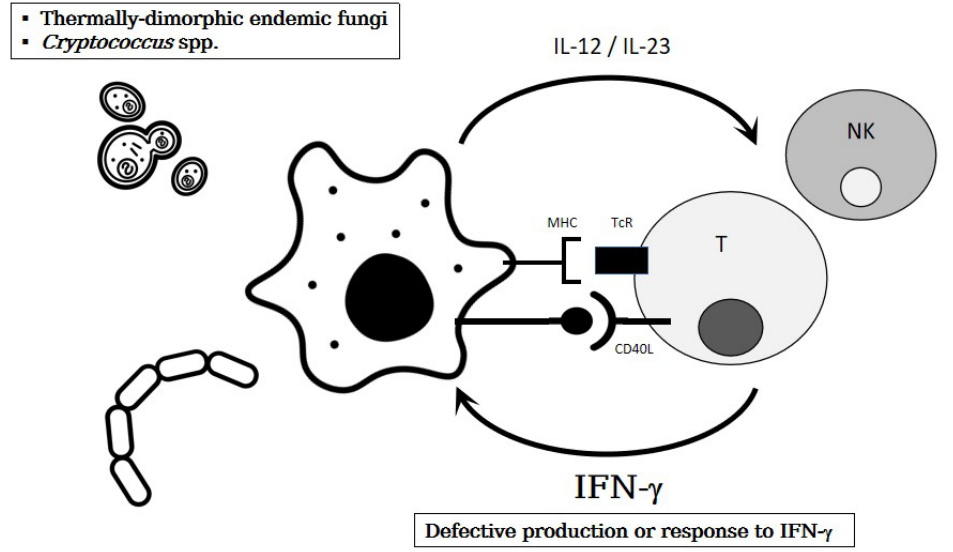
Figure 2. Impaired IFN- γ immunity increases susceptibility to mycoses from thermally-dimorphic endemic fungi and Cryptococcus